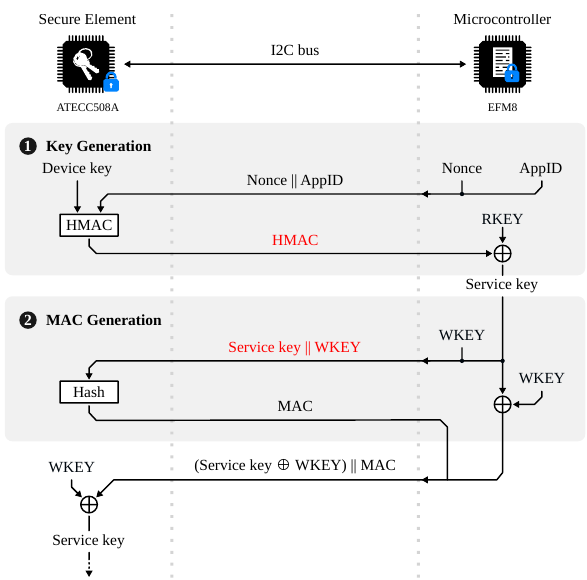
Figure 2: Part of the Nitrokey FIDO U2F registration flow. Messages on the I2C bus highlighted in red need to be eavesdropped by an